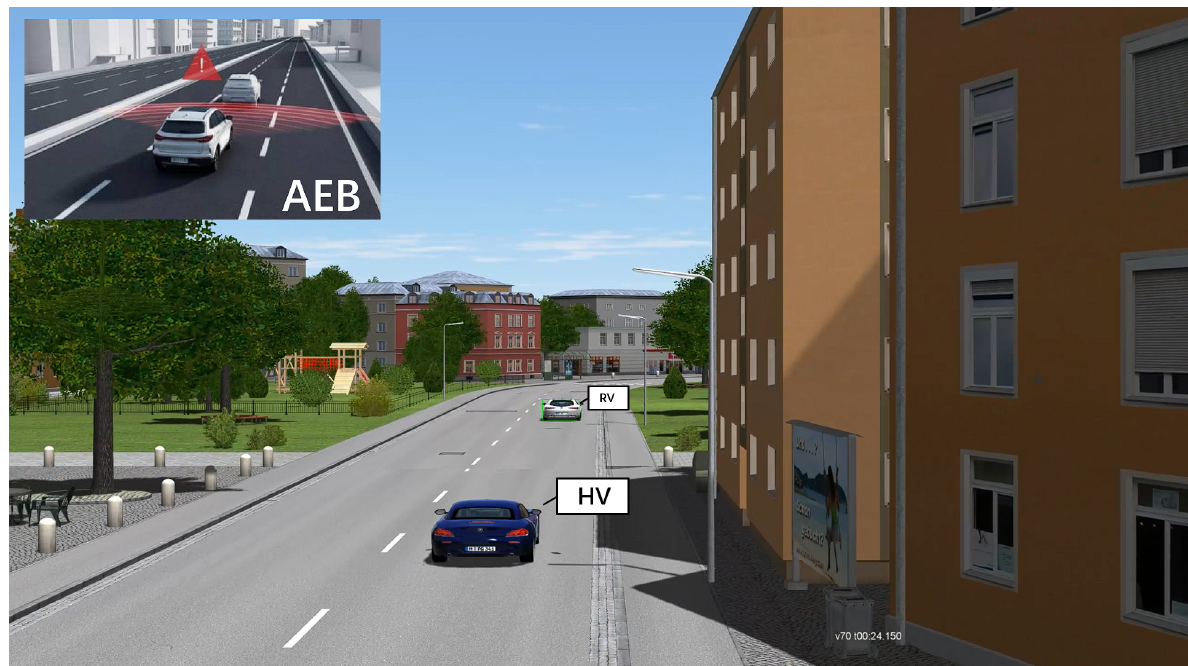
Figure 3. Autonomous Emergency Braking (AEB) function